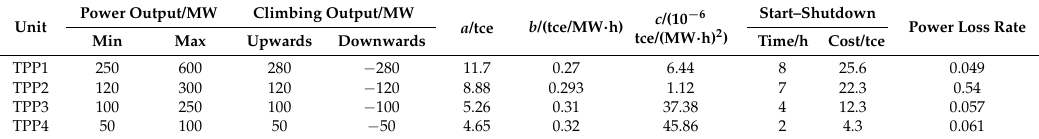
Table 2. The key parameters of the thermal power plant (TPP) operation.